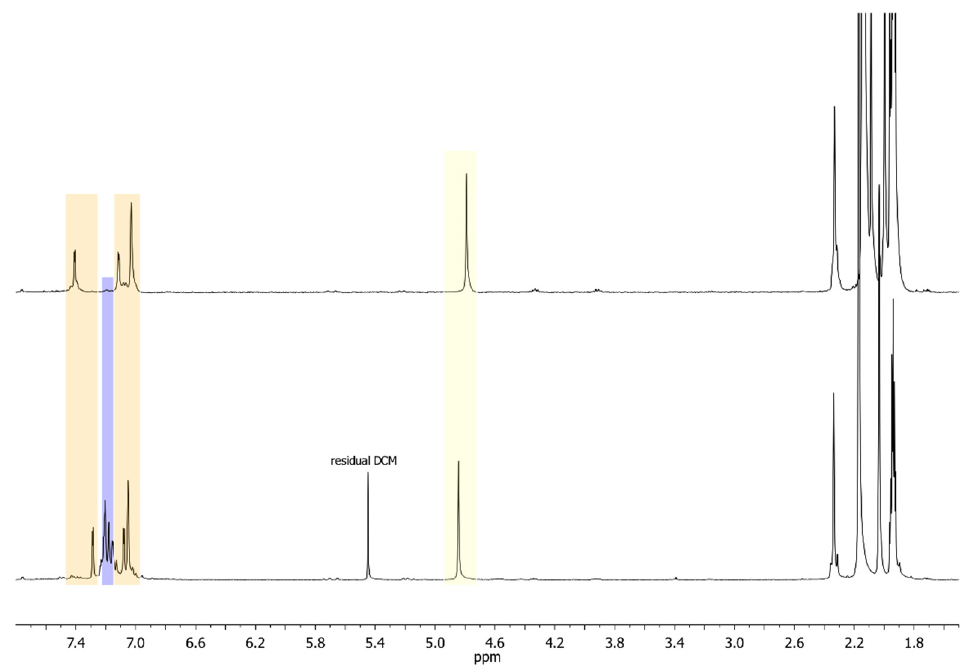
Figure 1. Comparison of the 1 H-NMR spectrum of complex 5 (lower spectrum) with the pristine dibromido complex 2 (upper spectrum).